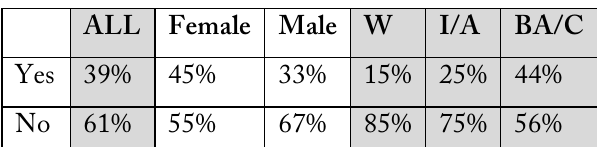
Table 6: Participation in protest